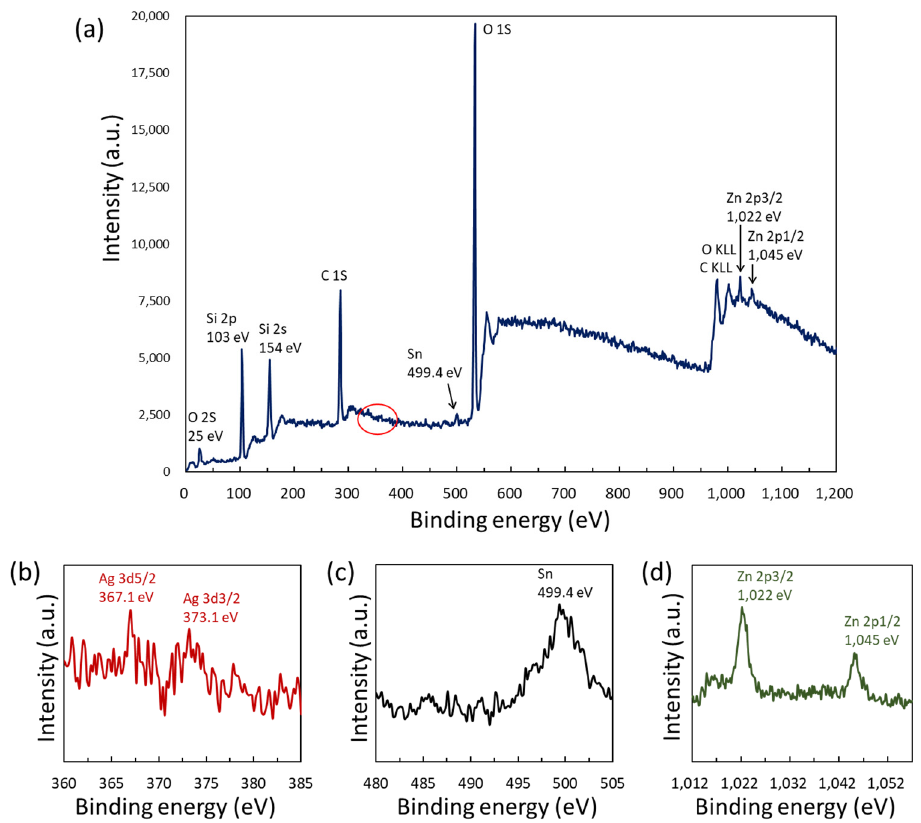
Figure 3. XPS spectra of ZTO/Ag/ZTO coatings: ( a ) full spectrum (the red circle indicates the barely seen signal from silver); ( b ) fine-scan spectrum for Ag; ( c ) fine-scan spectrum for Sn; ( d ) fine-scan spectrum for Zn. Peak assignment is shown accordingly.